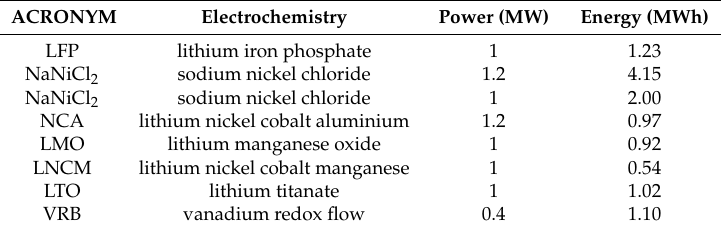
Table 1. Storage lab of Codronganos (Sardinia) installed secondary batteries starting from the cell level.